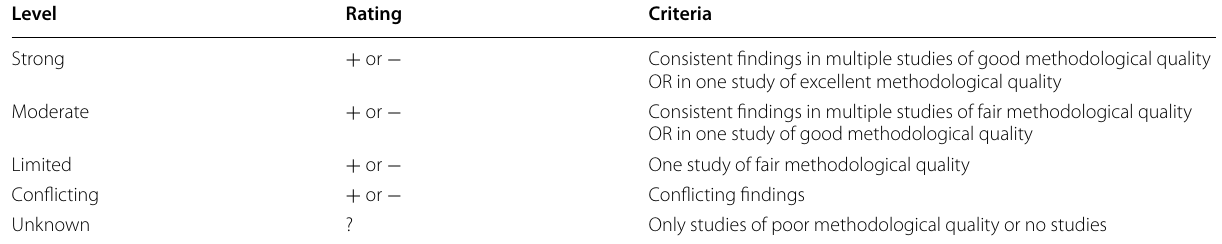
Table 2 Level of evidence rating